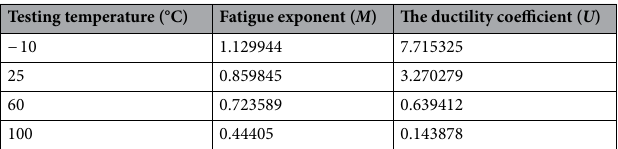
Table 5. The morrow equation constants versus the testing temperature.